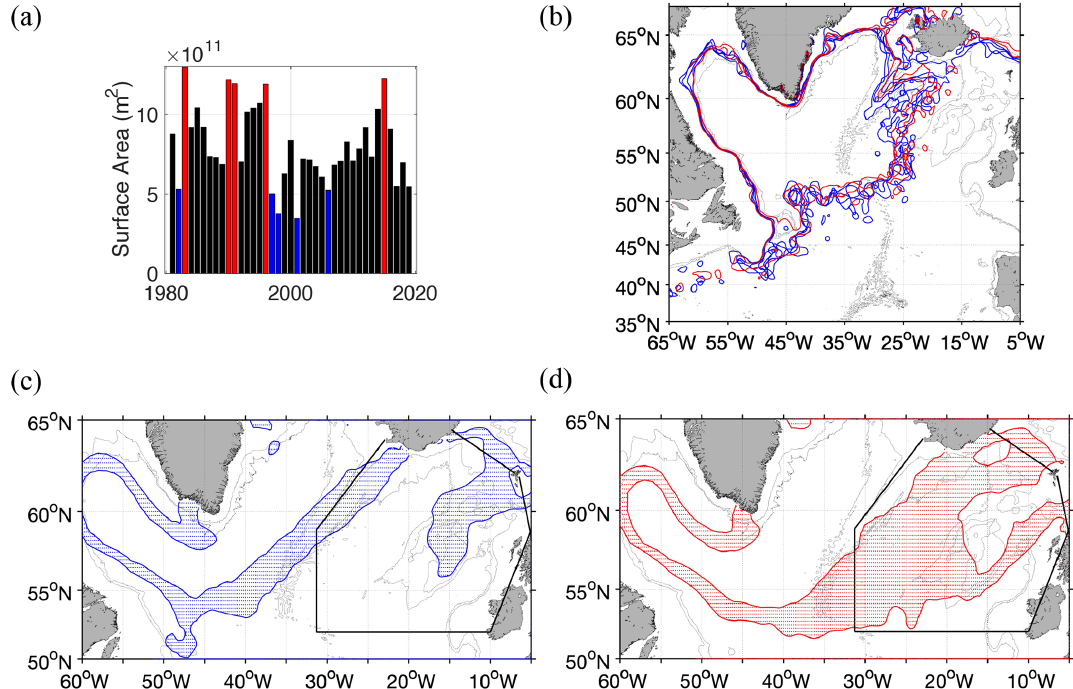
Figure 7. (a) Surface density area (m 2 ) in winter (December to April) for density higher than 27.3kgm − 3 over the black box indicated in panel (c) . (b) Blue (red) contours show the subpolar gyre boundaries in January during winters of “small” (“large”) area, as identified in panel (a) . (c, d) Surface density area 27.3–27.5kgm − 3 averaged during winters of small (blue) and large (red) area, as identified in panel (a)